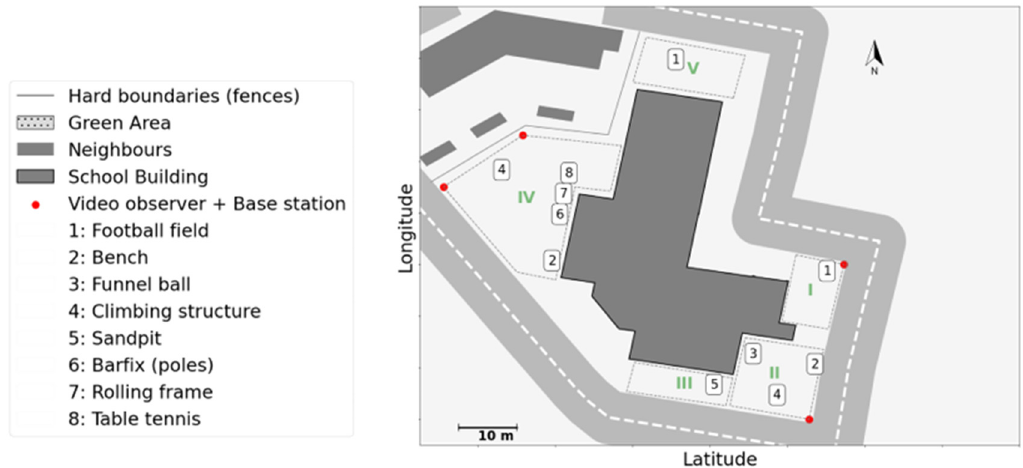
Figure 1. The layout of school A .